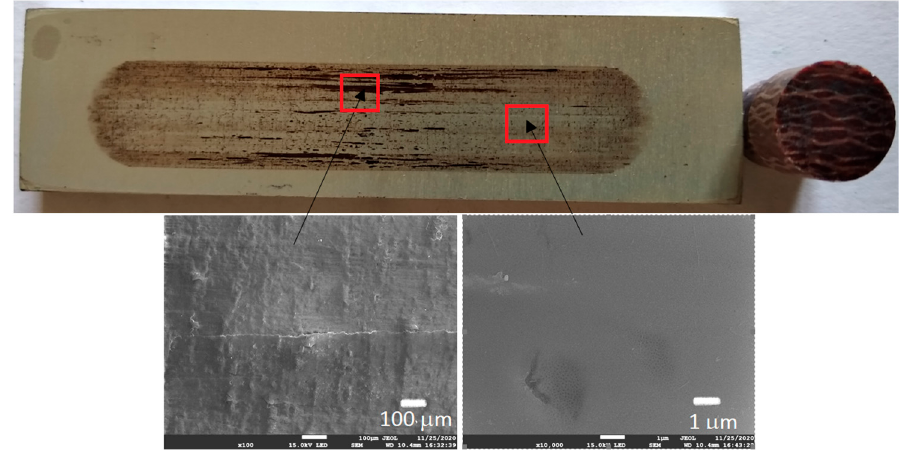
Figure 7. Photographs and SEM micrographs of Al 2 O 3 tribological pairs after a tribological test with PF + jute.